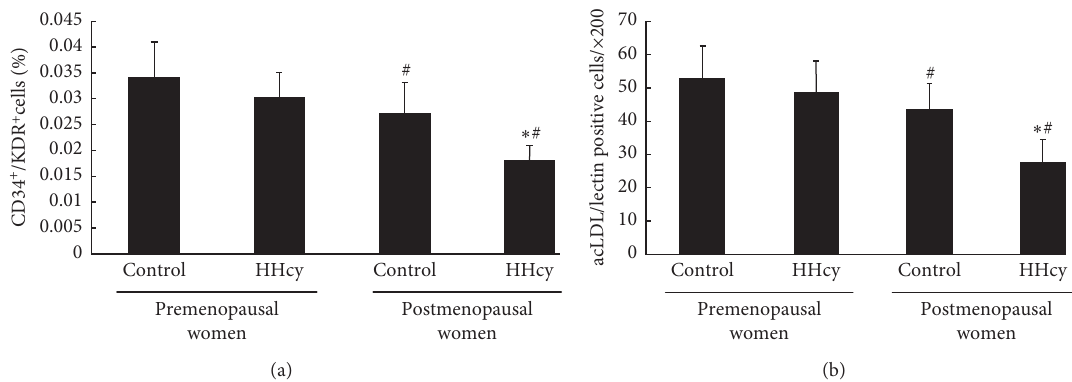
Figure 1: The number of circulating EPCs in the four groups is shown as follows. Evaluated by (a) FACS analysis and (b) phase-contrast fluorescent microscope, the number of circulating EPCs in postmenopausal women was lower than those in premenopausal women. The EPC number in hyperhomocysteinemia in postmenopausal women was lower than that in control postmenopausal women. However, there was no significant difference in the level of the number of circulating EPCs between control and hyperhomocysteinemia premenopausal women. Data are given as mean ± SD. ☆ vs. control; # vs. premenopausal women.